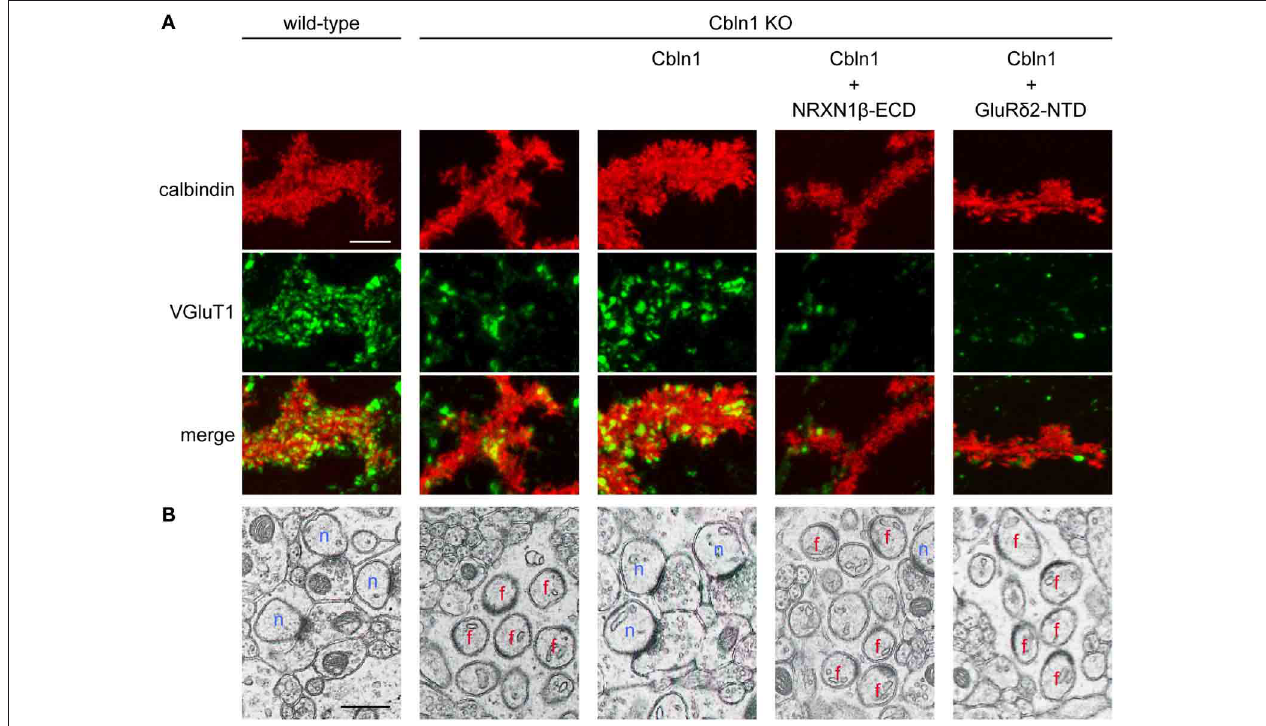
GluR δ 2-NTD. (B) Suppression of Cbln1 synaptogenic activity by NRXN1 β -ECD and GluR δ 2-NTD in vivo . Electron micrographs of cerebella from wild-type and Cbln1 KO mice and those from Cbln1 KO mice injected with Cbln1 together with or without NRXN1 β -ECD and GluR δ 2-NTD. In wild-type mice, all PC spines formed synaptic contacts with PFs. In Cbln1 KO mice, many PC spines lacked synaptic contacts (free spines). Injection of Cbln1 restored PF-PC connections in Cbln1 KO mice. The in vivo synatogenic activity of Cbln1 was suppressed by co-injection of NRXN1 β -ECD and GluR δ 2-NTD. n, normal synapses; f, free spines. Scale bars represent 5 μ m in (A) and 0.5 μ m in (B)